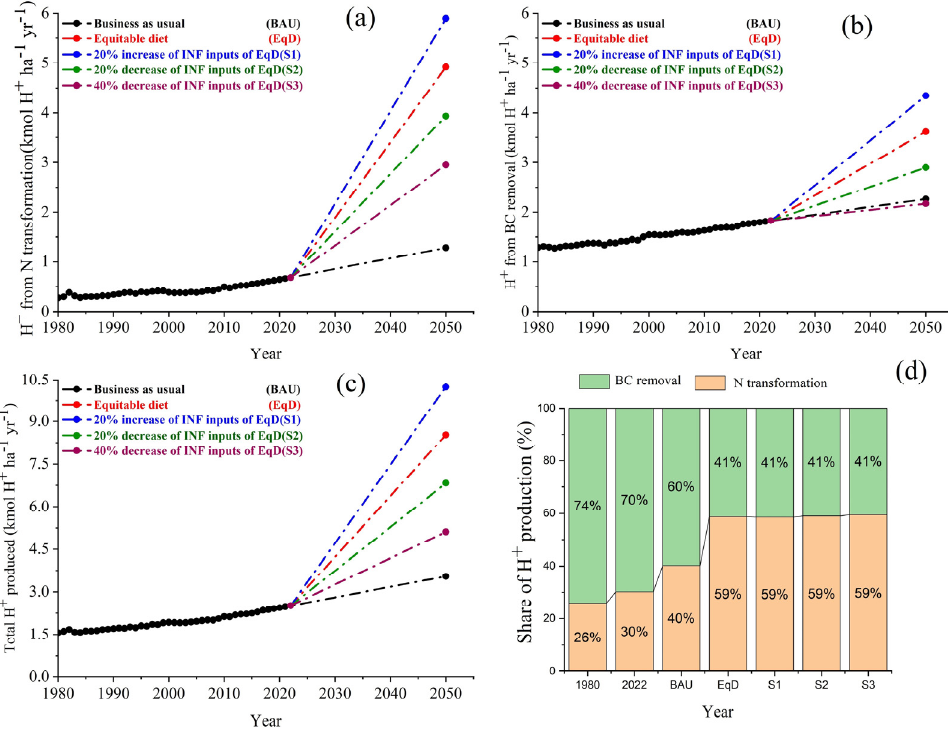
Figure 3. Variation in mean H + production from N nitrification and ( a ) mean total H + from basic cation removal ( b ) from all cropping systems; mean total H + production for all SSA croplands ( c ) and temporal share of H + production from N nitrification and basic cation removal of all cropping systems in SSA from 1980 to 2050 ( d ). Details of H + from different cropping systems (cereals, tubers, vegetables, and pulses (Figure S3).